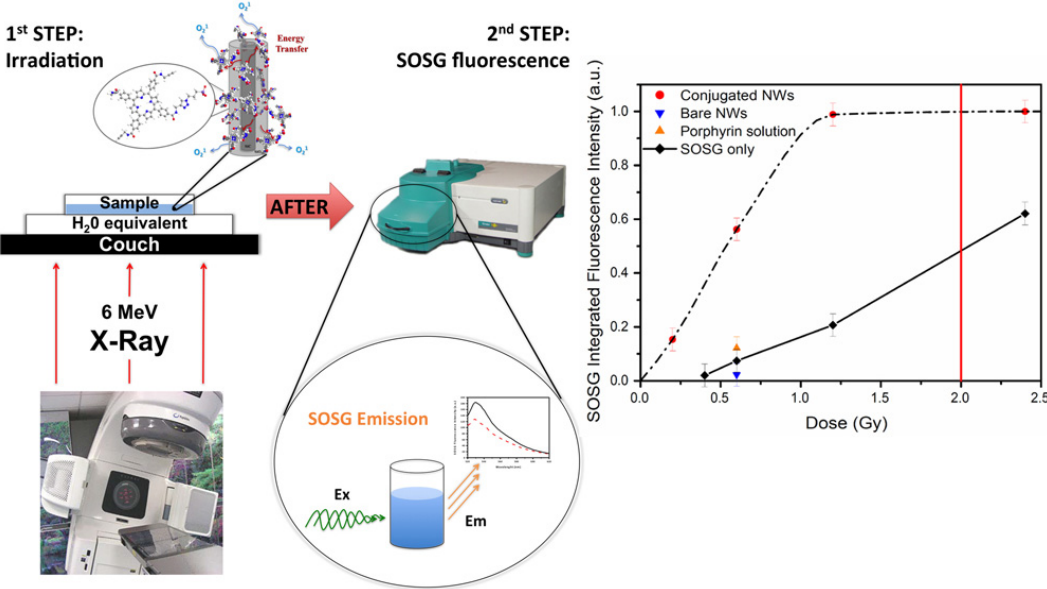
Figure 11. 1 O 2 production excited by X-rays in a radiation therapy setup. Sketch of the experimental steps: a dish containing the sample solution is put on the couch and irradiated from the bottom, and then it is transferred to a spectrophotometer to acquire the fluorescence spectrum of the SOSG marker. The plot reports the measured integrated fluorescence intensity, proportional to 1 O 2 generated, as a function of the radiation dose. The experimental points are obtained from a SOSG kit in water, with H 2 TPACPP-functionalized NWs (red circles) or without NWs (black diamonds). The orange triangle at 0.6 Gy is the experimental point obtained from the SOSG kit in a water solution of mere porphyrin, while the blue triangle is obtained from the SOSG kit in a water suspension of NWs as grown. The usual dose for clinical treatment (2 Gy) is indicated by the red vertical line [2].